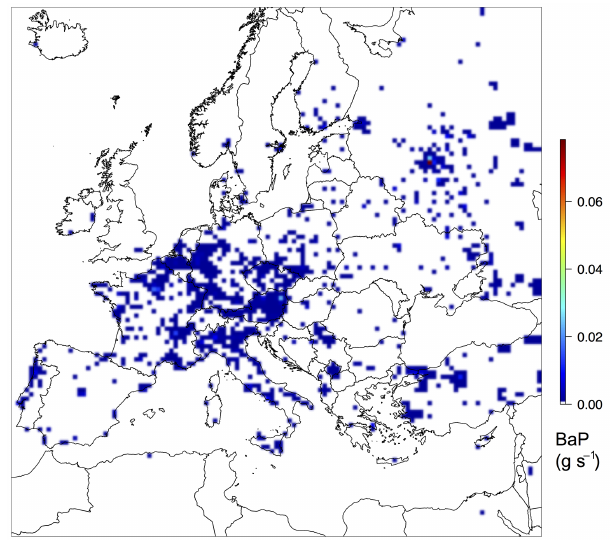
Figure 1. Study domain and 2006 annual grid cell mean BaP emis- sion flux (gs − 1 ) at the